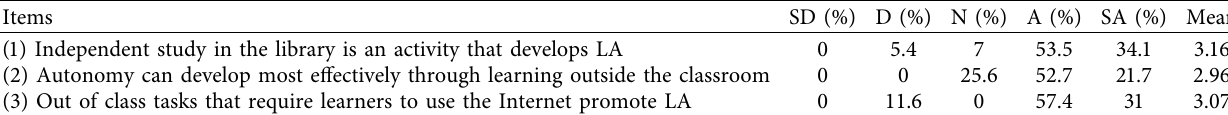
Table 4: Descriptive statistics of the technical orientation of